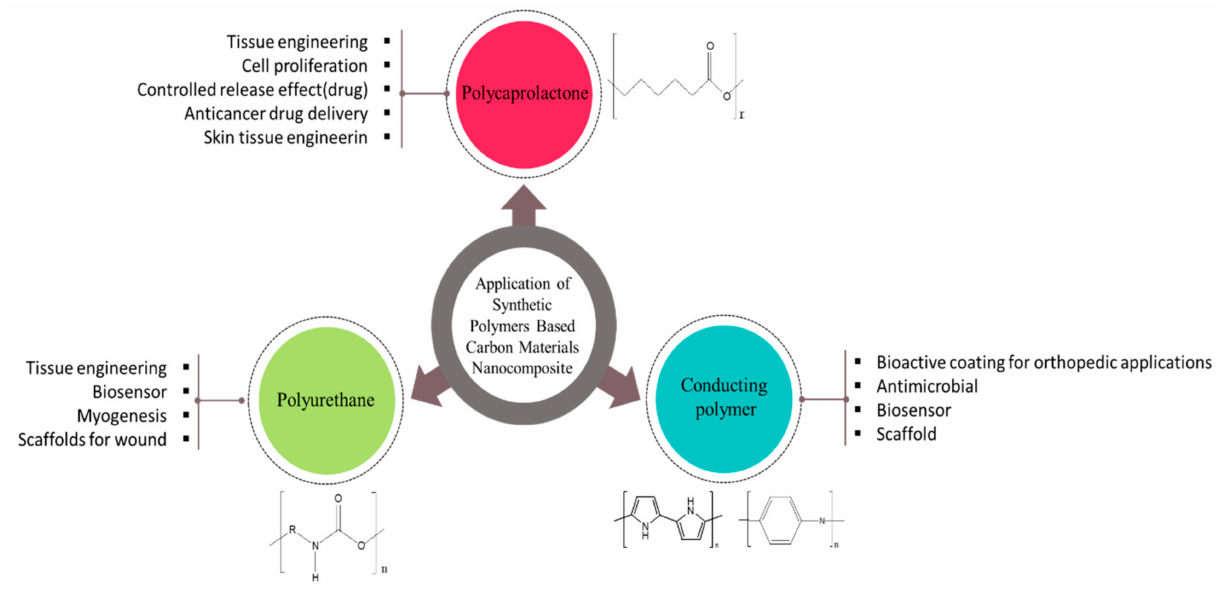
Figure 1. Schematic illustration for the most common synthetic polymers for biomedical